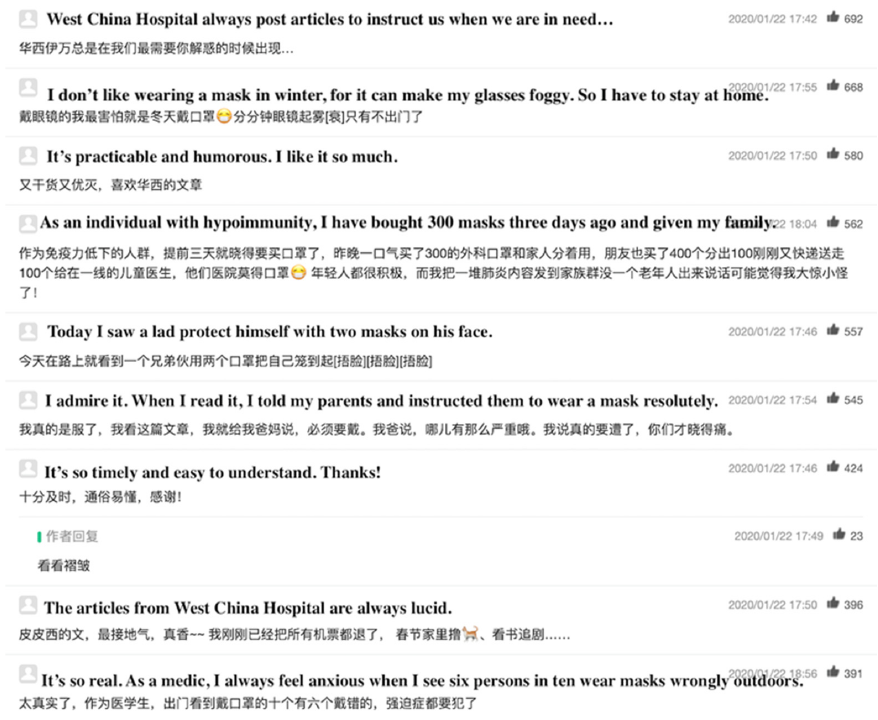
Figure 10. Screenshot of a review page. From: West China Hospital. Can you go out without a mask? Experts